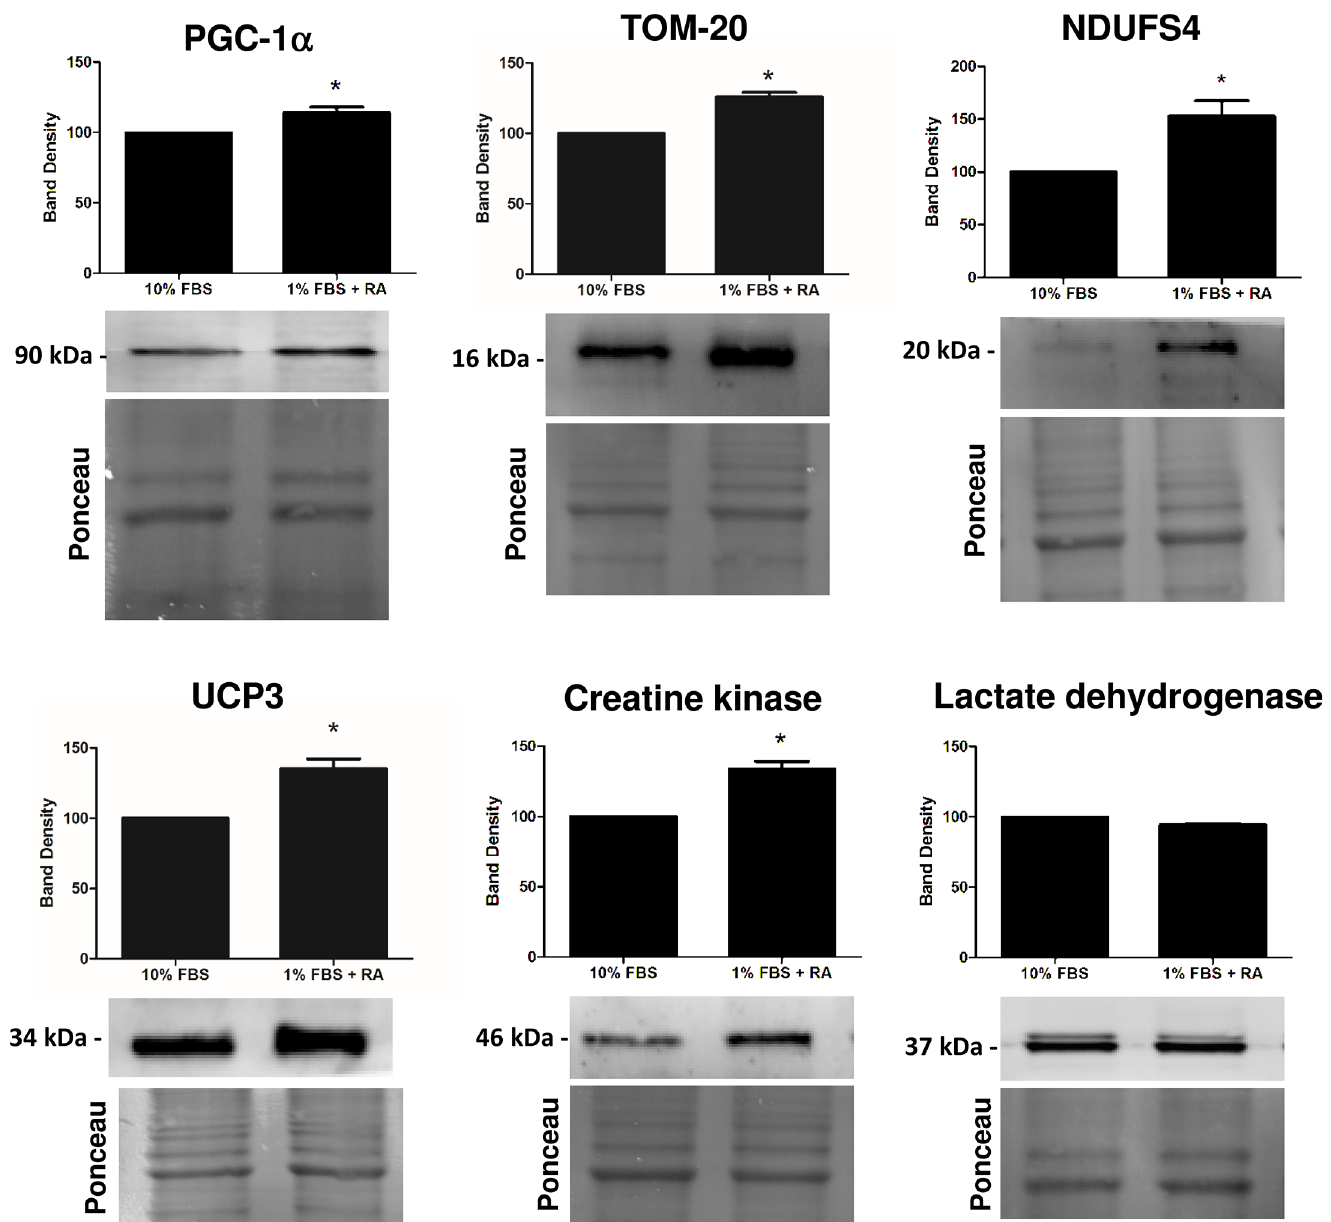
Fig 2. Semi-quantification by Western blotting of selected proteins involved on mitochondrial function and metabolism. Protein content of PGC1 α , TOM20, complex I NDUFS4 subunit, uncoupling protein 3, creatine kinase and lactate dehydrogenase was measured as described in the materials and methods section. H9c2 myoblasts were differentiated by being cultured in 1% FBS medium supplemented with 1 μ M RA and maintained for 5 days. Total extracts from both cellular groups were collected. Ponceau labeling represents the loading control and was used to normalize data. Data represent the mean ± SEM of 4 – 5 independent experiments ( * ) p < 0.05 versus respective undifferentiated group.